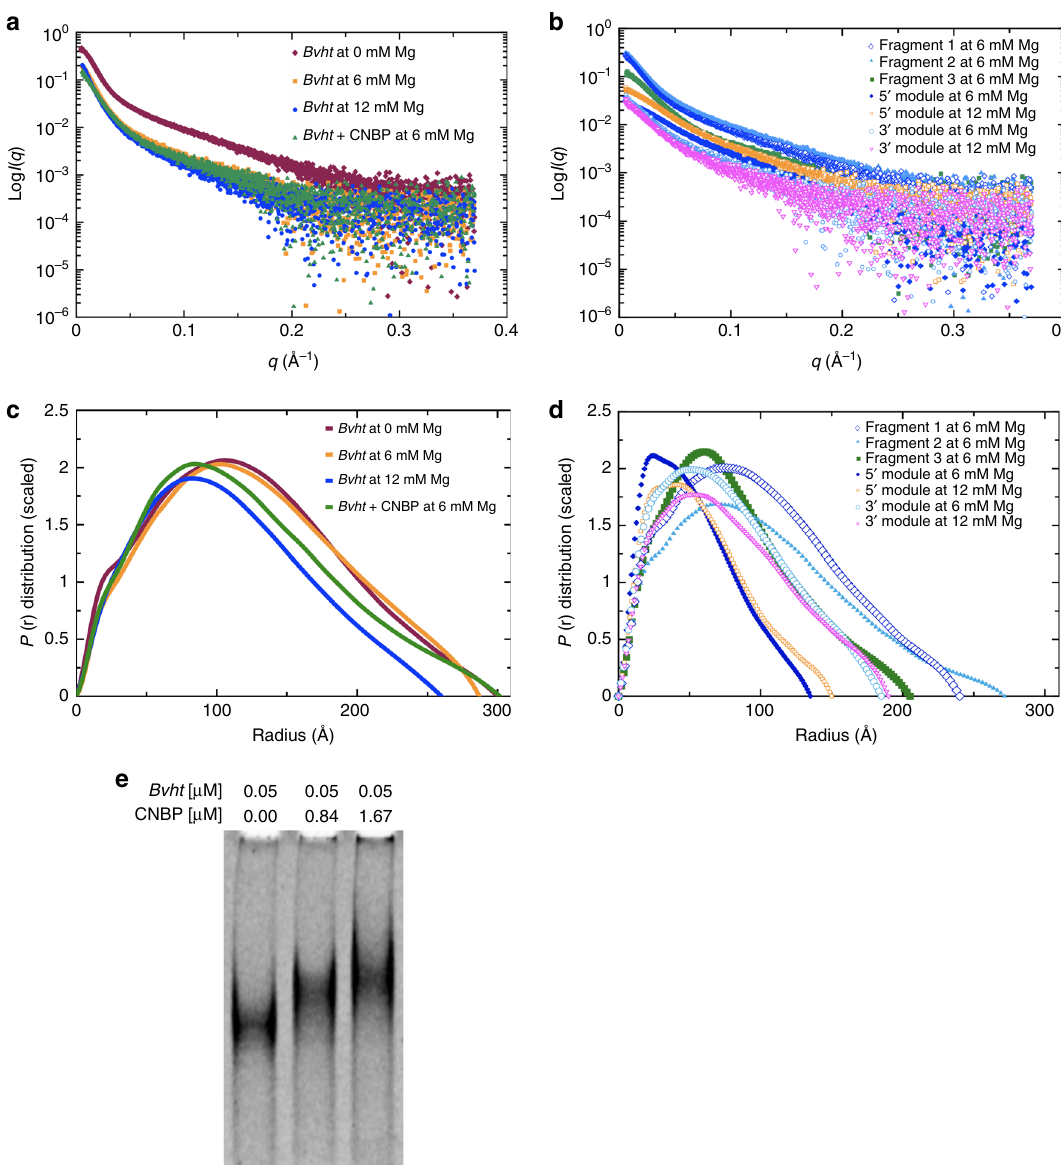
Fig. 1 SAXS and EMSA data for lncRNA Bvht . a Scattering intensity vs. scattering angle ( q = 4 π sin θ / λ ), indicating the dependence on Mg 2 + concentration and effect of Bvht- CNBP complex formation. b Scattering intensity vs. scattering angle for isolated subregions of Bvht lncRNA. c Pair-distance distribution function for full-length Bvht at various Mg 2 + concentrations and for Bvht -CNBP complex. d Pair-distance distribution function for subregions of Bvht . e EMSA for full-length Bvht with increasing CNBP